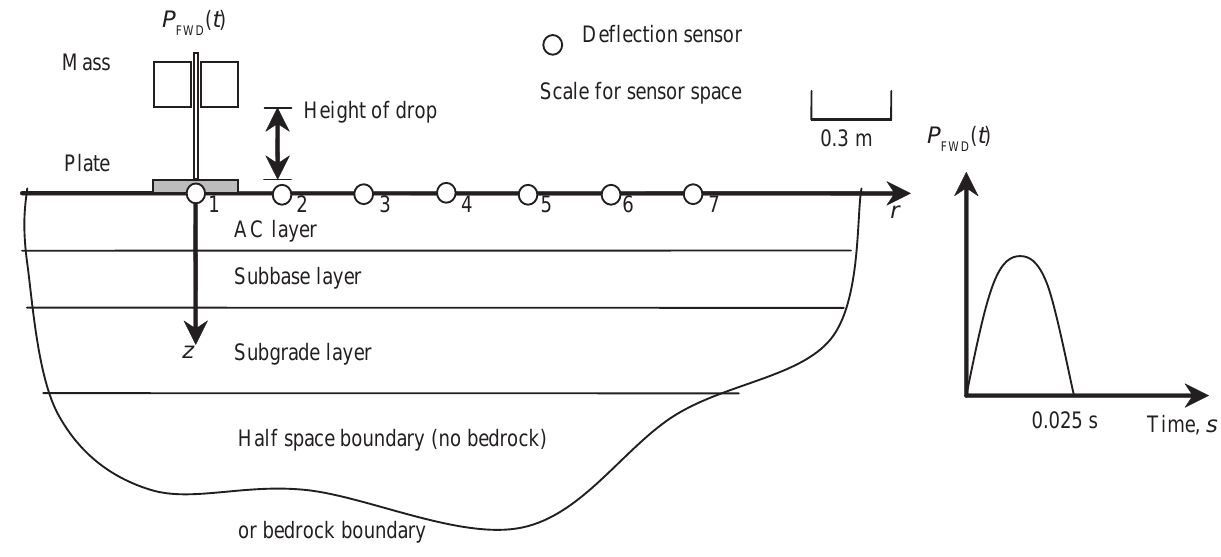
Fig. 1. Layered pavement structure and FWD test